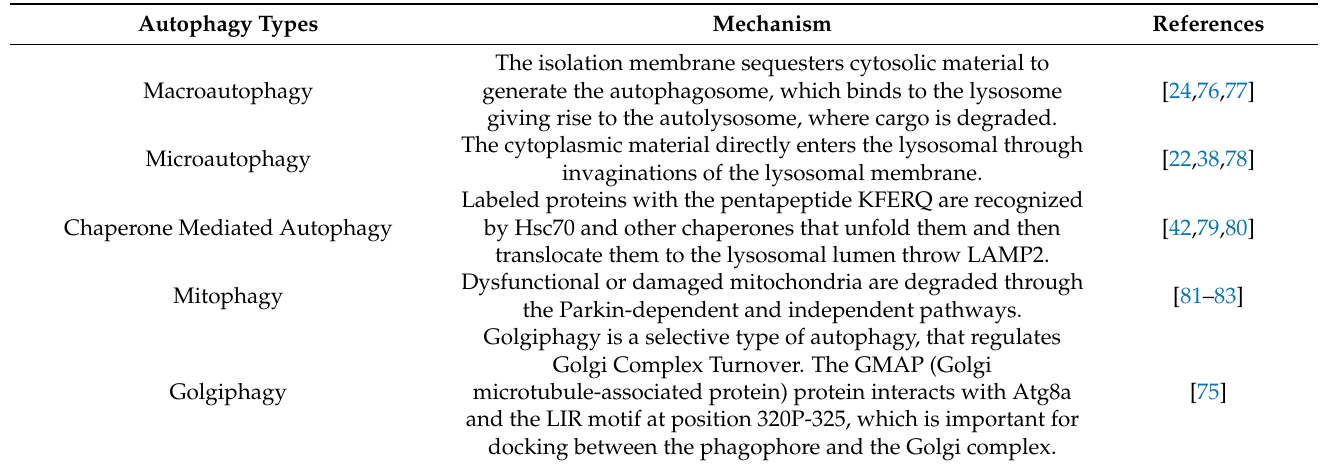
Table 2. Autophagy types and mechanisms